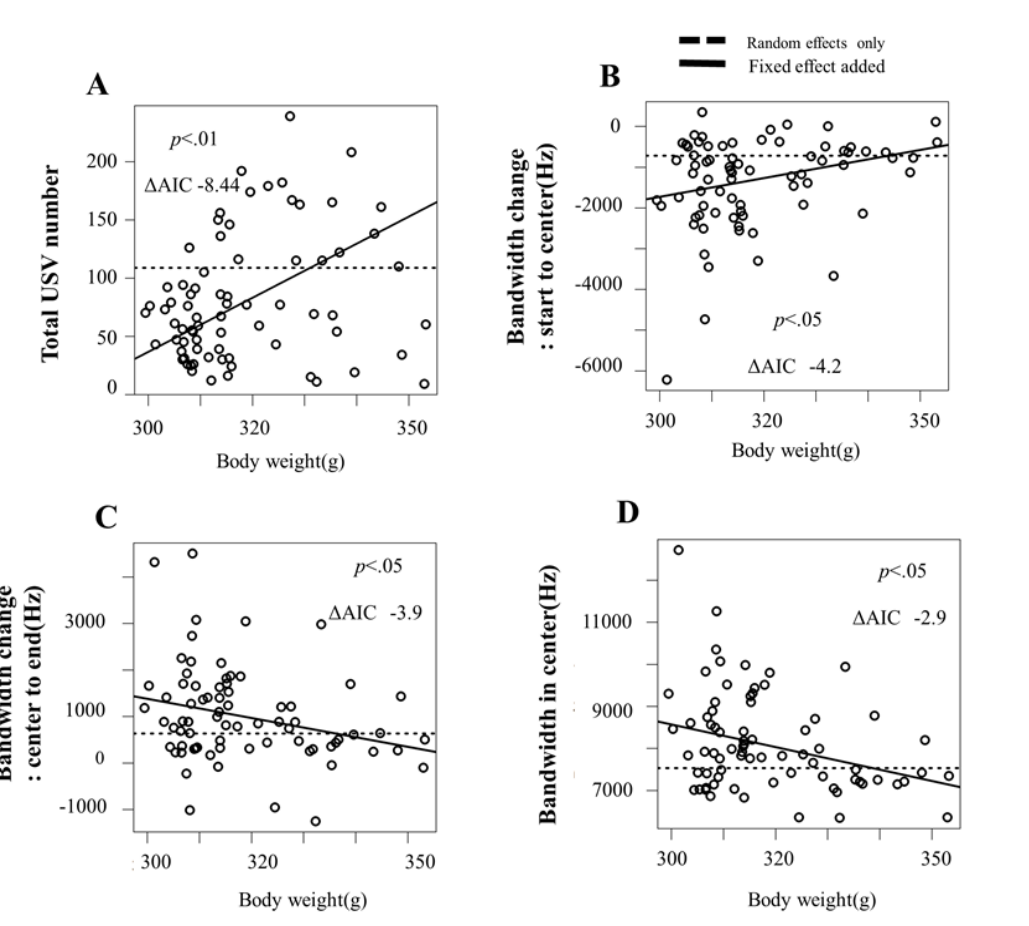
Figure 5 . Differences in USV acoustic parameters in relation to body weight. A) Total USVs number. B) Bandwidth change from start to center. C) Bandwidth change from center to end. D) Bandwidth in center. Each open circle represents the averaged feature value for each day and each individual. Random effects were the length of the waiting phase, individual differences, and group. The fixed effect was body